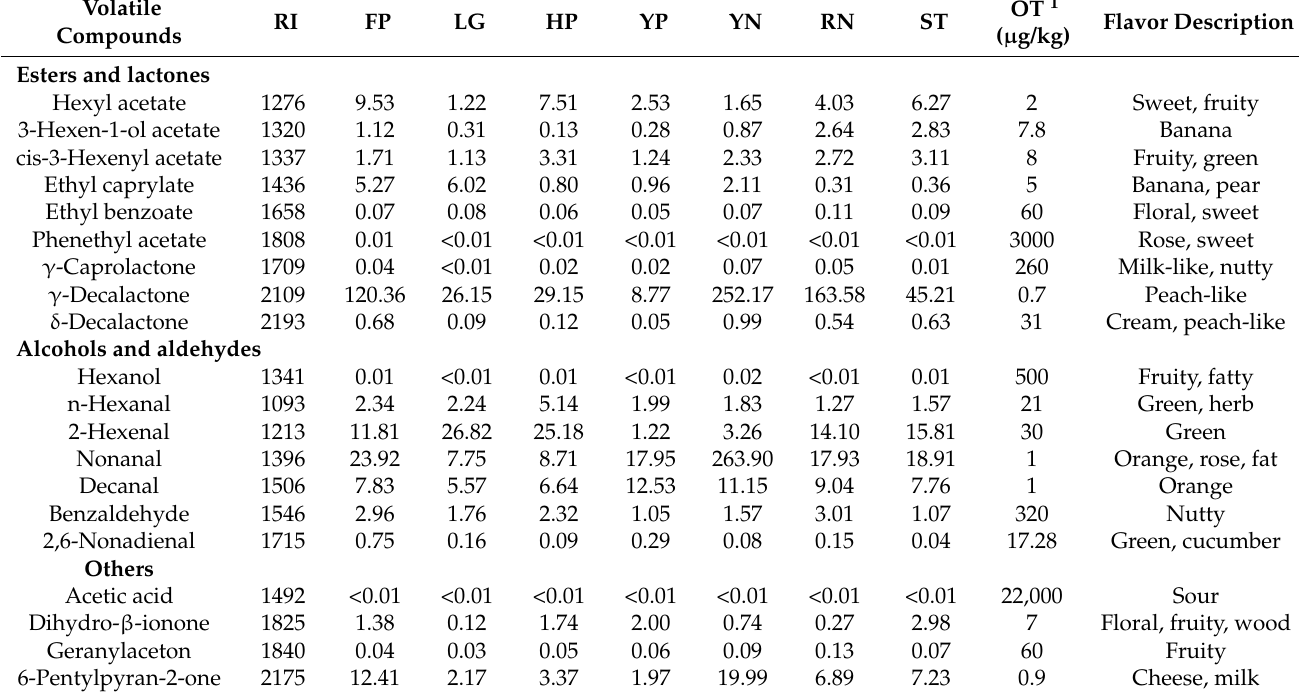
Table 7. OAVs of main volatile compounds found in flesh of seven